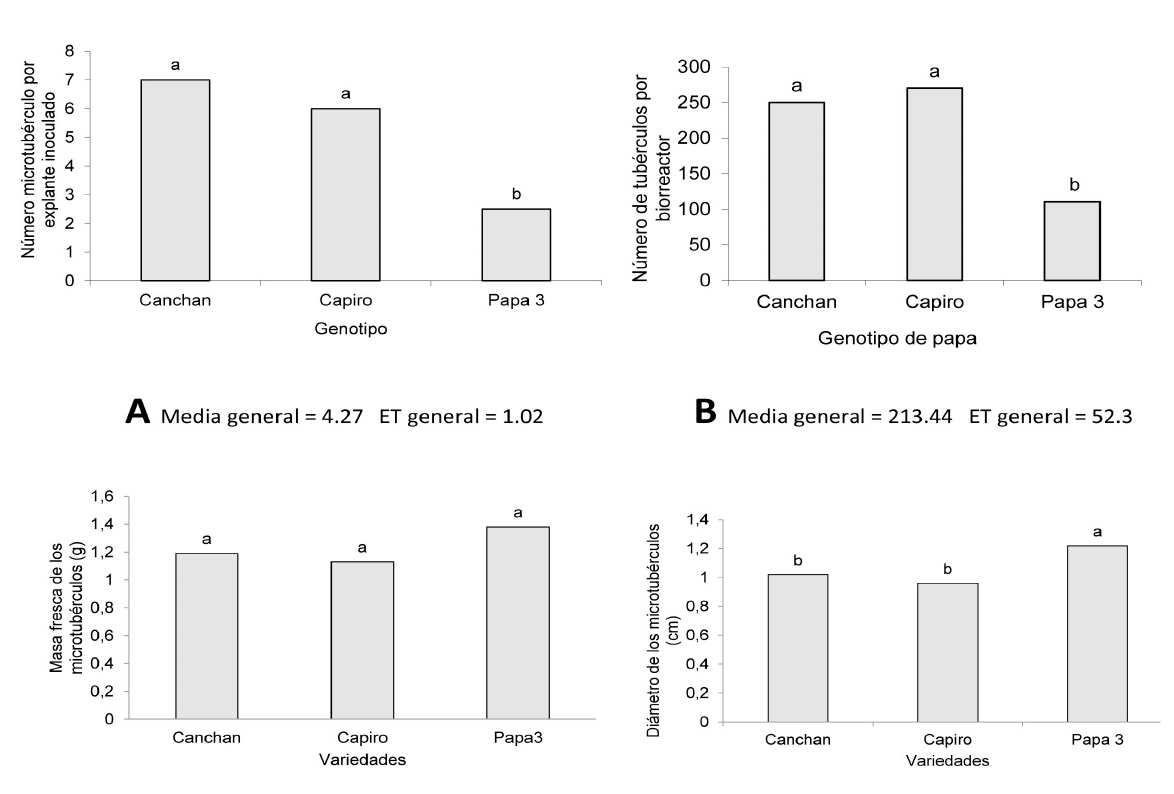
Figure 2. Pre-basic seed in the number of microtubers per bioreactor (A), number of microtubules per explant (B), fresh mass of microtubers (C), and diameter of the microtubers (D). In each figure, means with equal letters do not have statistically significant differences (monofactorial ANOVA, Tukey p> 0.05). For statistical processing, the number of microtubers was transformed according to y = (y + 0.5) x 0.5. Data represent the mean of three BIT /